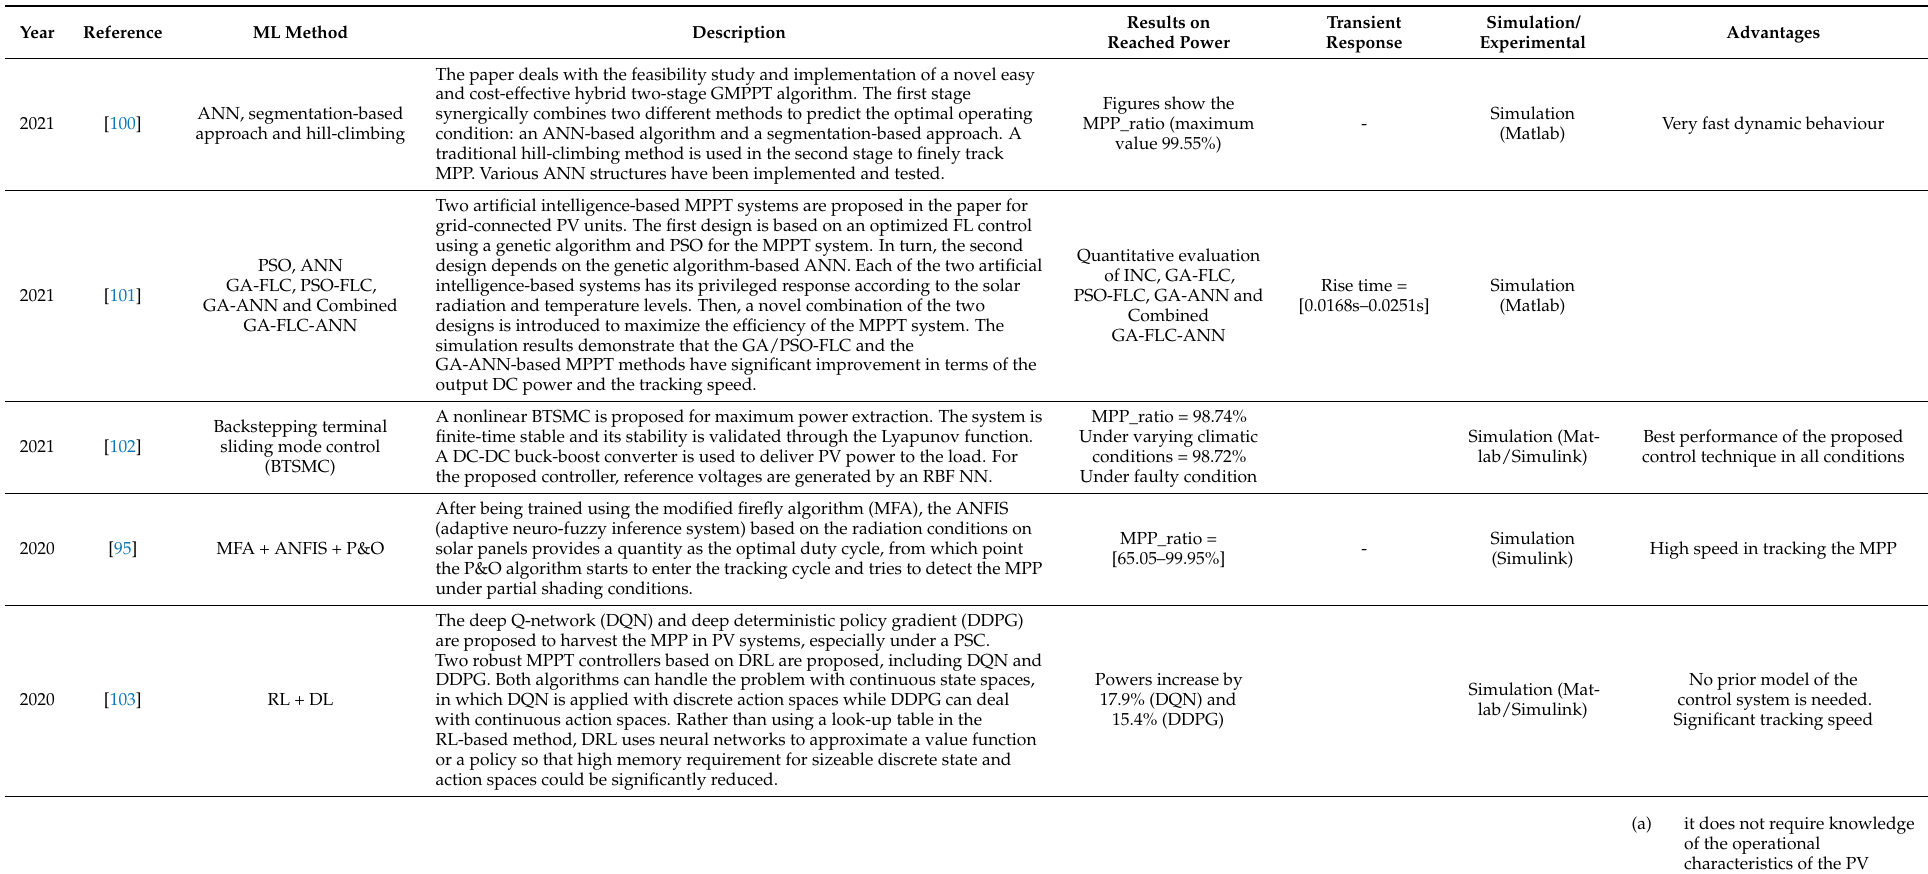
Table 7. Papers for PV MPPT. Publication year considered: